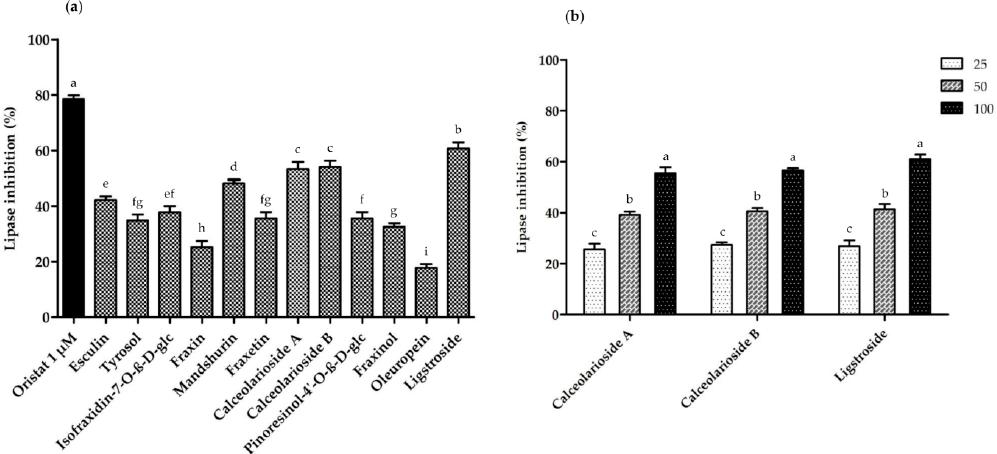
Figure 9. The anti-lipase activity of twelve compounds isolated from F. mandshurica : ( a ) percent lipase inhibition of the isolated compounds from F . mandshurica bark at the concentration of 100 μ M. Orlistat was used as a positive control; ( b ) percent lipase inhibition of calceolarioside A and B, and ligstroside at three concentrations of 25, 50 and 100 µ M. Di ff erent letters indicate significant di ff erences based on one-way ANOVA followed by Tukey’s multiple comparison test ( p <